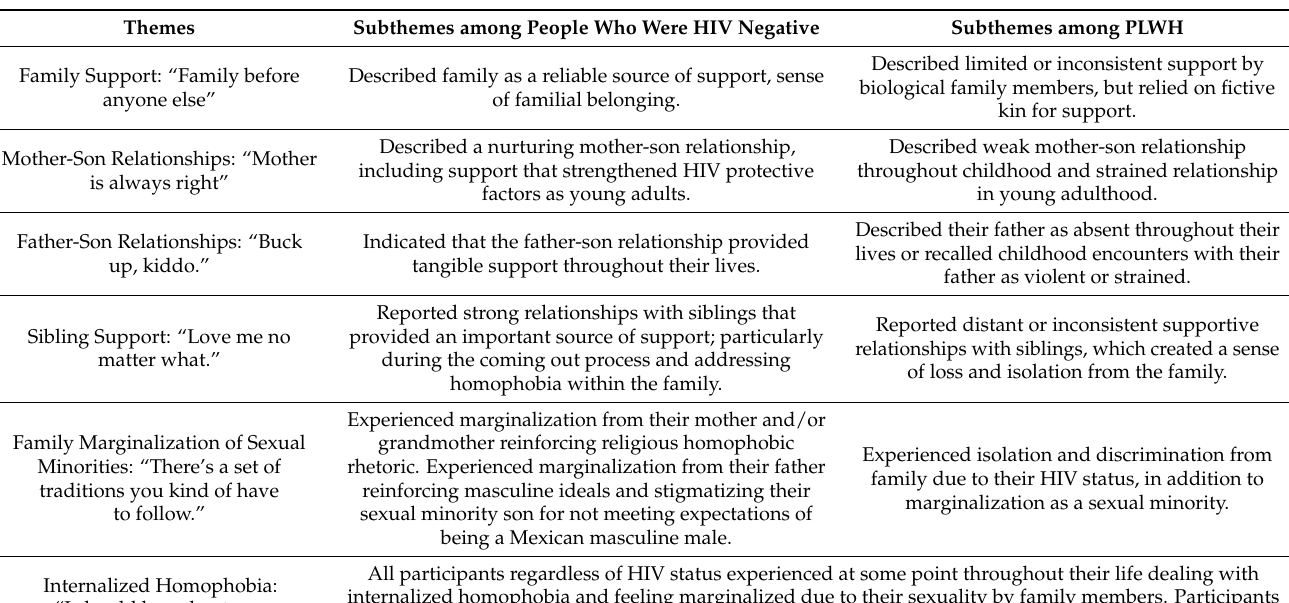
Table 3. Themes and subtheme descriptions related to family, marginalization, and HIV